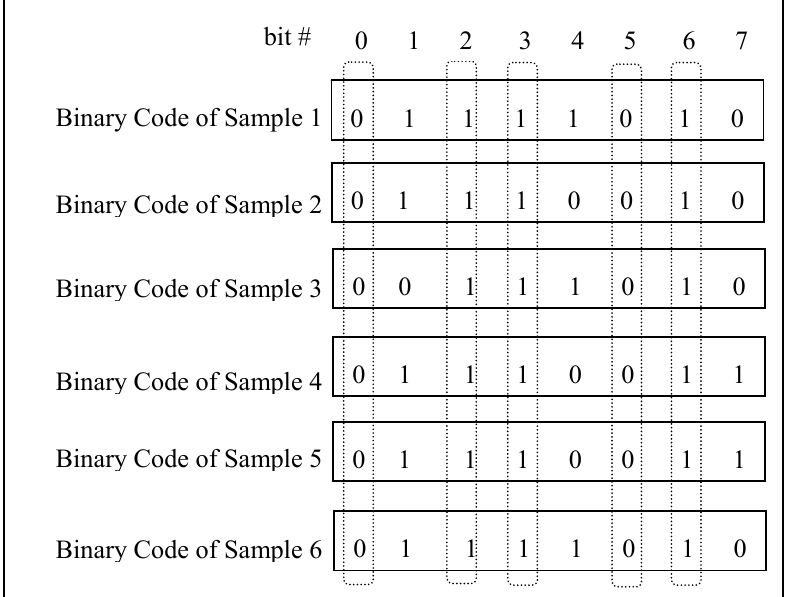
Figure 2. Examples of binary